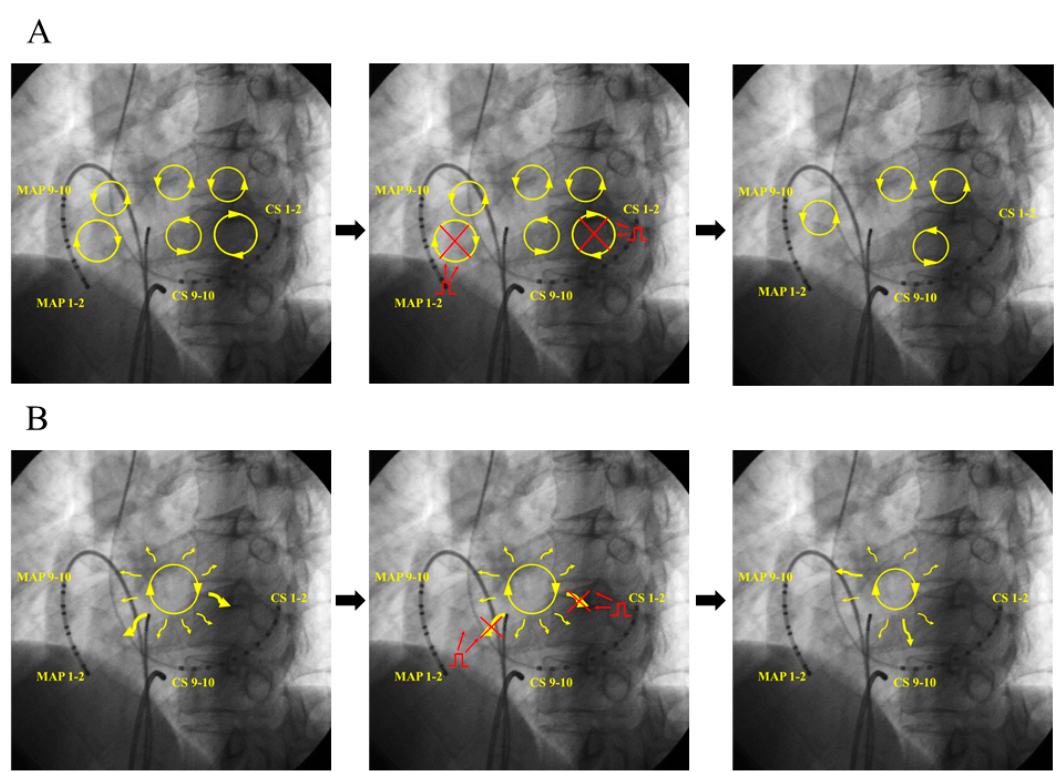
Figure 8. Three possible hypotheses for the mechanisms of AF termination. ( A ) Multi-wavelet reentry theory; Pacing stimulations collide the dominant circuit of a small reentrant circuit, and the balance of a multi-reentry collapses. The AF becomes unstable and cannot sustain, resulting in eventual termination. ( B ) Mother Rotor theory; Pacing stimuli block a main pathway of the mother rotor, preventing it from sustaining, resulting in eventual termination. CS = coronary sinus.